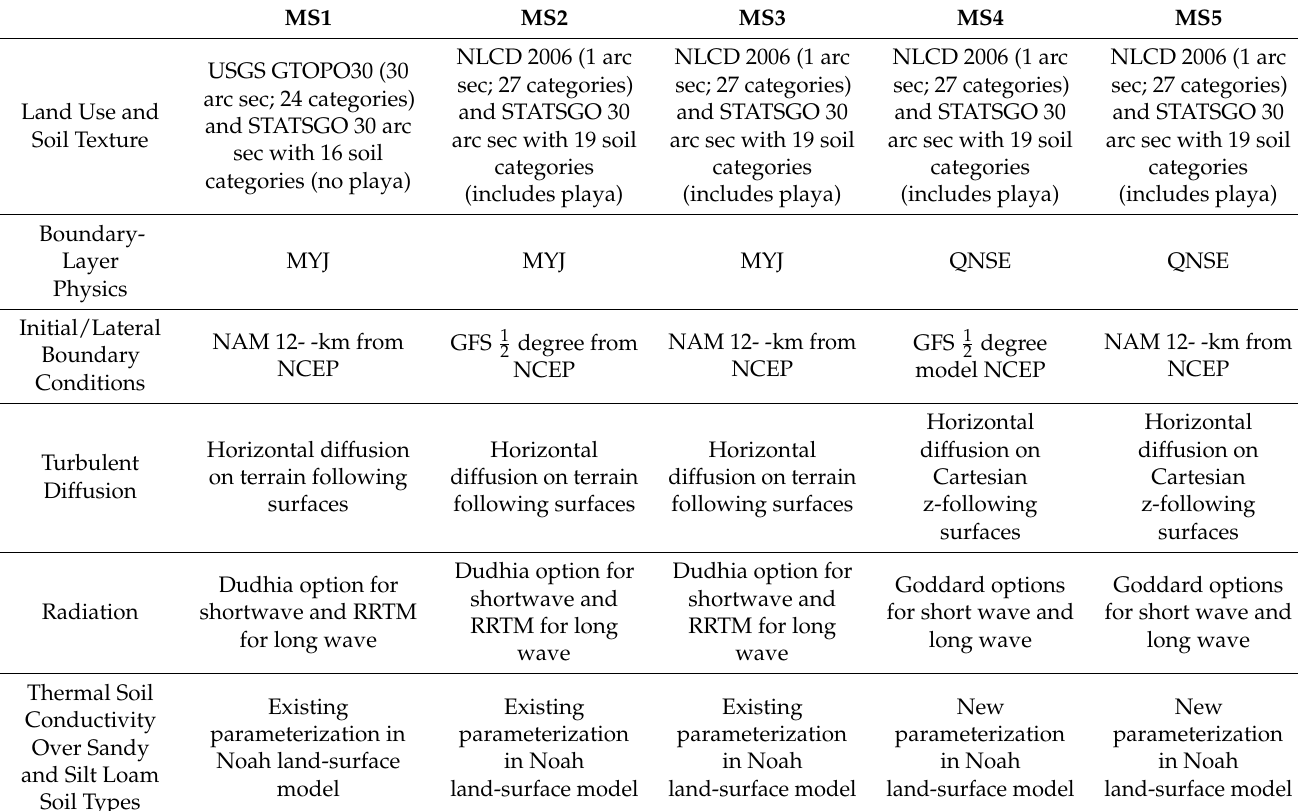
Table 1. Datasets and parameterization schemes used for each model setup performed in this study. The NLCD 2006 40 land-use categories were remapped to the original 24 USGS categories with three additional added using NCAR for playa, white sand, and lava over CONUS. For soil texture, NCAR also added playa, white sand, and lava categories over CONUS. MS1 MS2